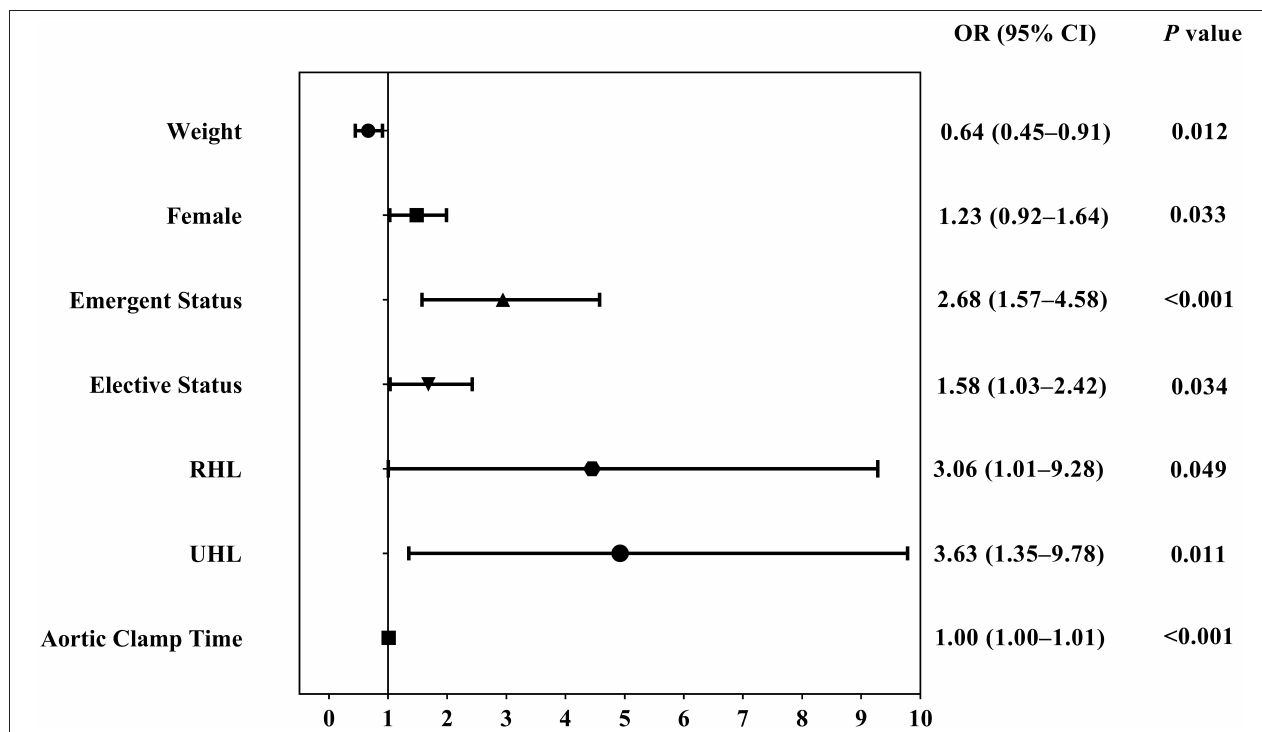
FIGURE 5 | Forest plot showing adjusted OR of factors associated with in-hospital mortality in patients experiencing both cardiopulmonary bypass and aortic clamp procedure. CI, confidence interval; OR, odds ratio, RHL, right heart lesions; UHL, univentricular heart lesions.